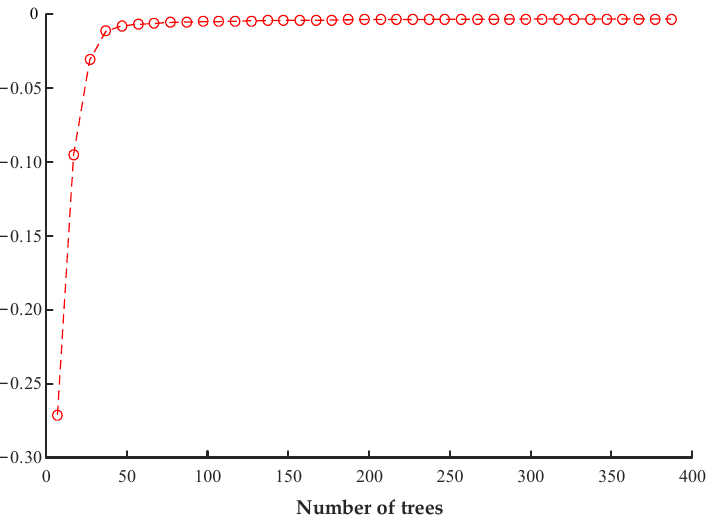
Figure 13. Number selection of trees. The closer the logarithmic loss value is to zero, the more accurate the XGBoost classifier is. From Figure 13, when the number of trees is 54, the logarithmic loss value is − 0.0061, which is the largest value, so it is determined that the number of trees is 54. Through the selection calculation, the optimal parameters of the XGBoost model are shown in Table 4, and the remaining parameters are set to default values. Table 4. Parameters for XGBoost.